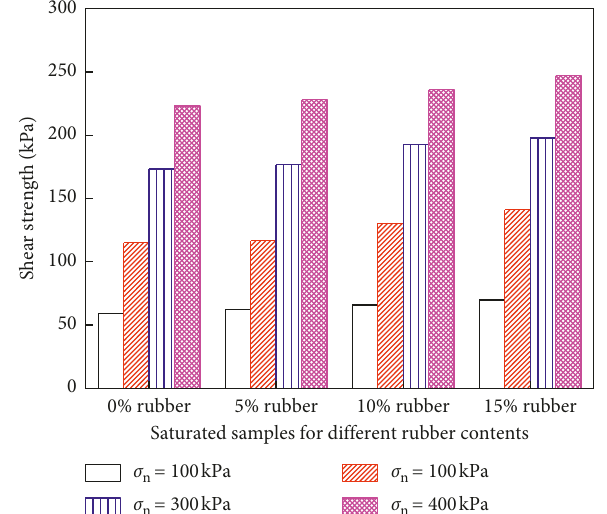
Figure 5: Shear strength of saturated